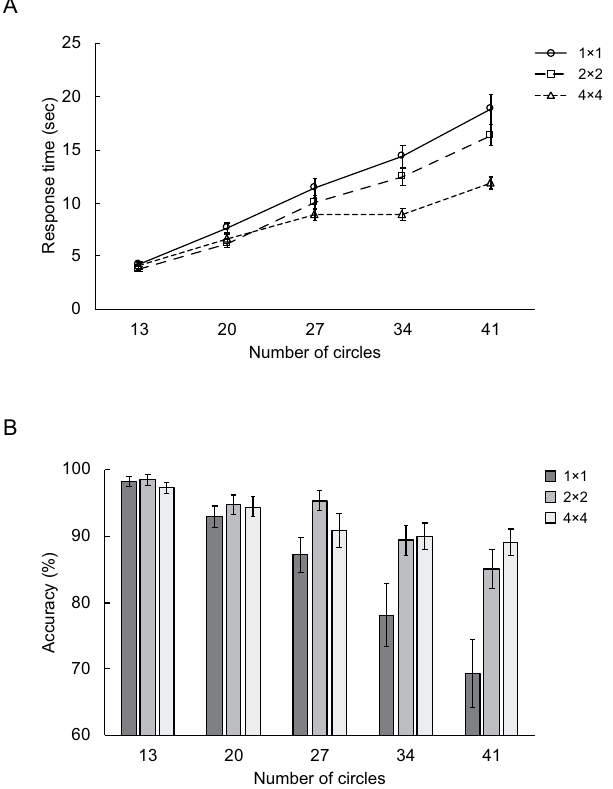
Figure 2. ( A ) Mean RT and ( B ) mean accuracy for target numerosities, separated according to the factor of divider. Error bars represents standard